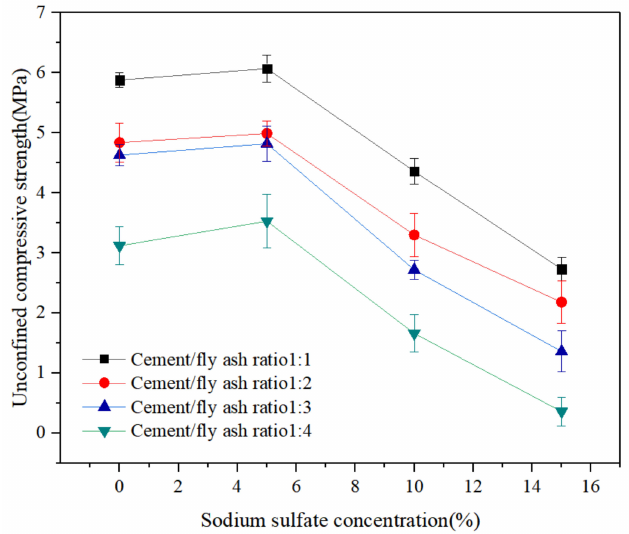
Figure 5. E ff ect of the sodium sulphate concentration on the compressive strength of the specimens with di ff erent high-sulphur fly ash